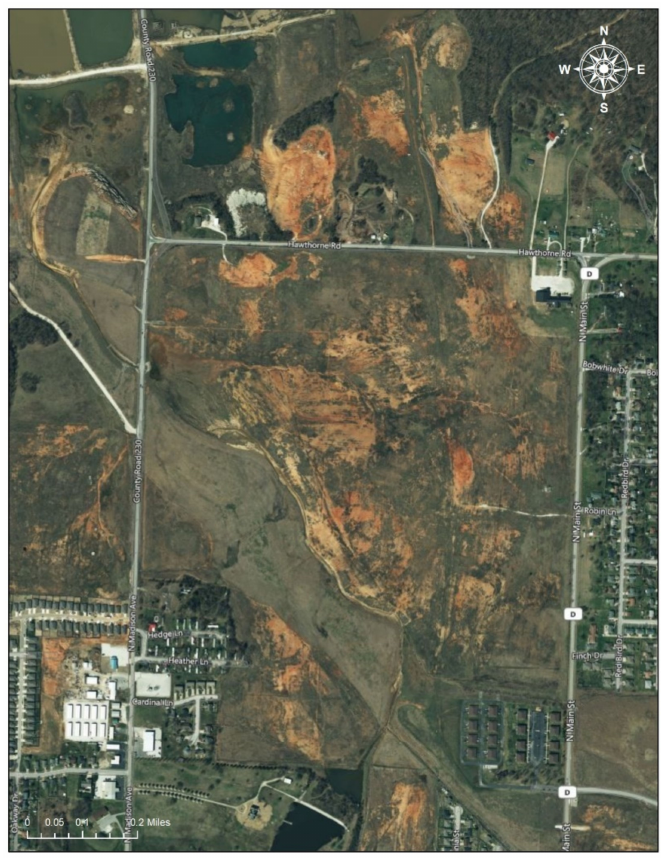
Figure 3. Oronogo-Duenweg Mining Belt Site. Note: The Oronogo-Duenweg Mining Belt Site was one of the major mine waste areas near Joplin, Missouri. The satellite imagery, obtained from Google, shows that the site has left marks (the reddish brown areas) since it was inactive in the 1970s (Date taken: 1 August 2020). The image in the Figure 3 is eligible for the Fair Use of a copyrighted work from Google Map